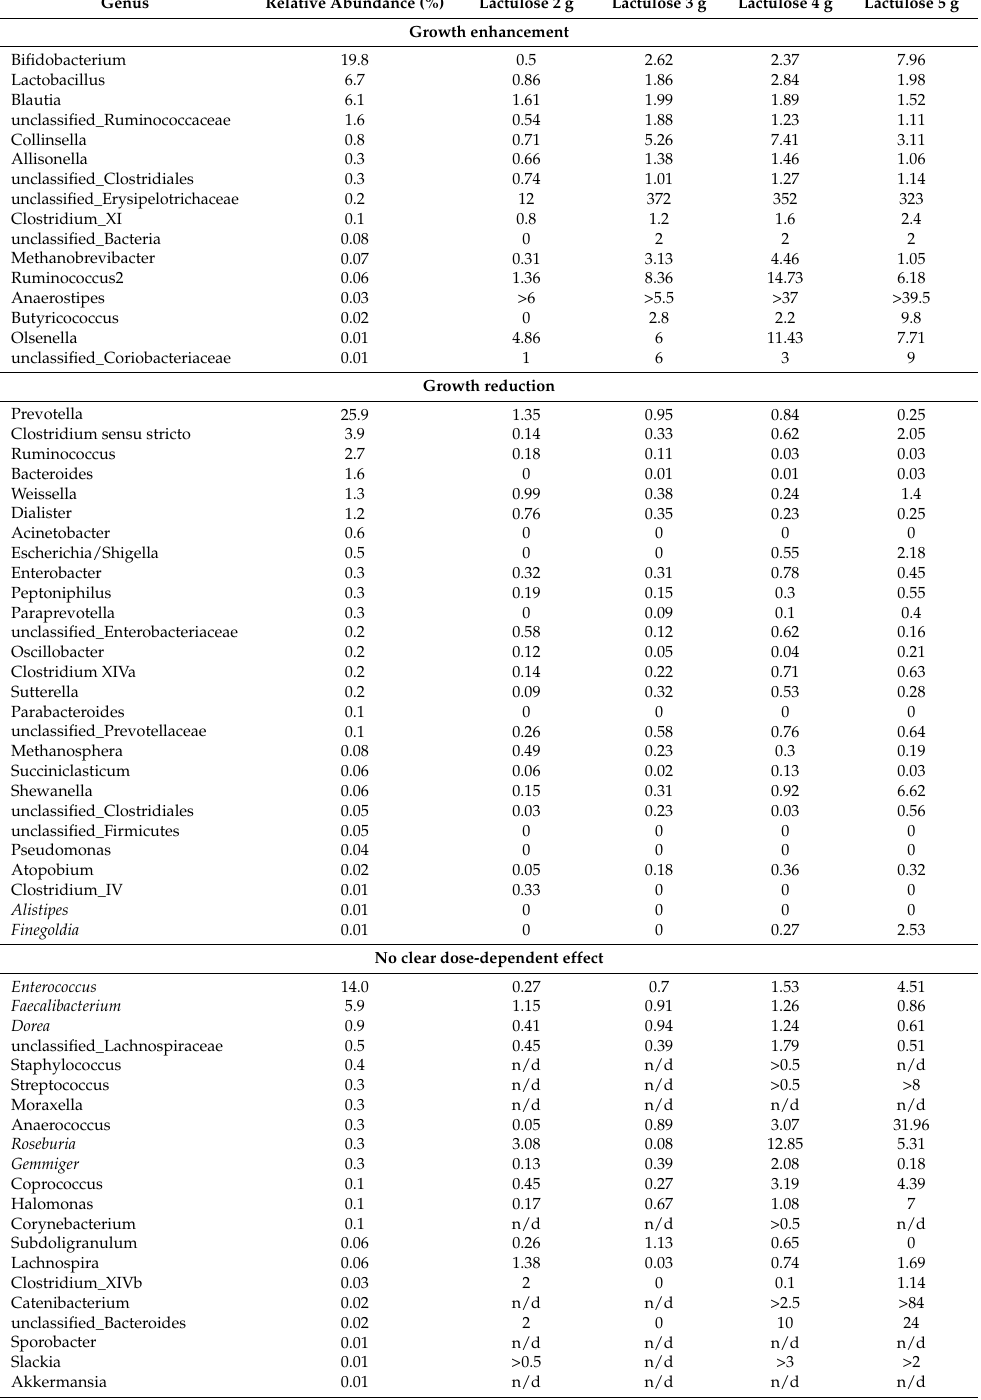
Table 1. Relative change of bacterial genera after 120 h fermentation experiments in TIM-2 ( n = 2). Genus Relative Abundance (%) Lactulose 2 g Lactulose 3 g Lactulose 4 g Lactulose 5 g Growth enhancement